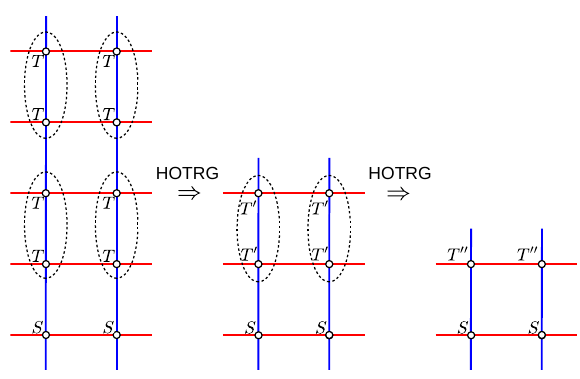
Figure 5 . The (cid:12)rst step of the algorithm. Blue (red) line denotes the temporal (spatial) direction. After two iterations of the HOTRG procedure, the temporal size of the tensor T is reduced to be one.